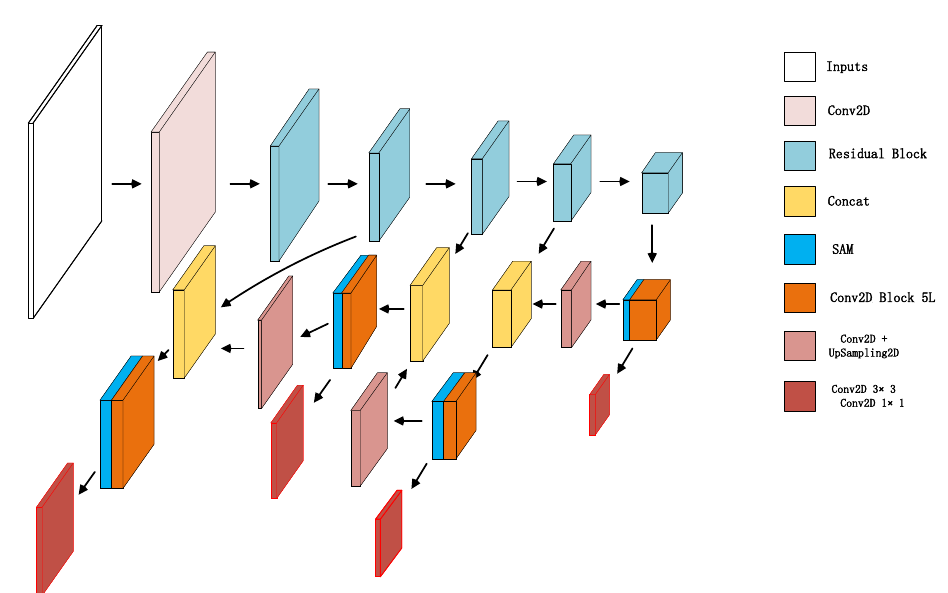
Figure 4. Improved YOLO-v3 attention mechanism fusion model.